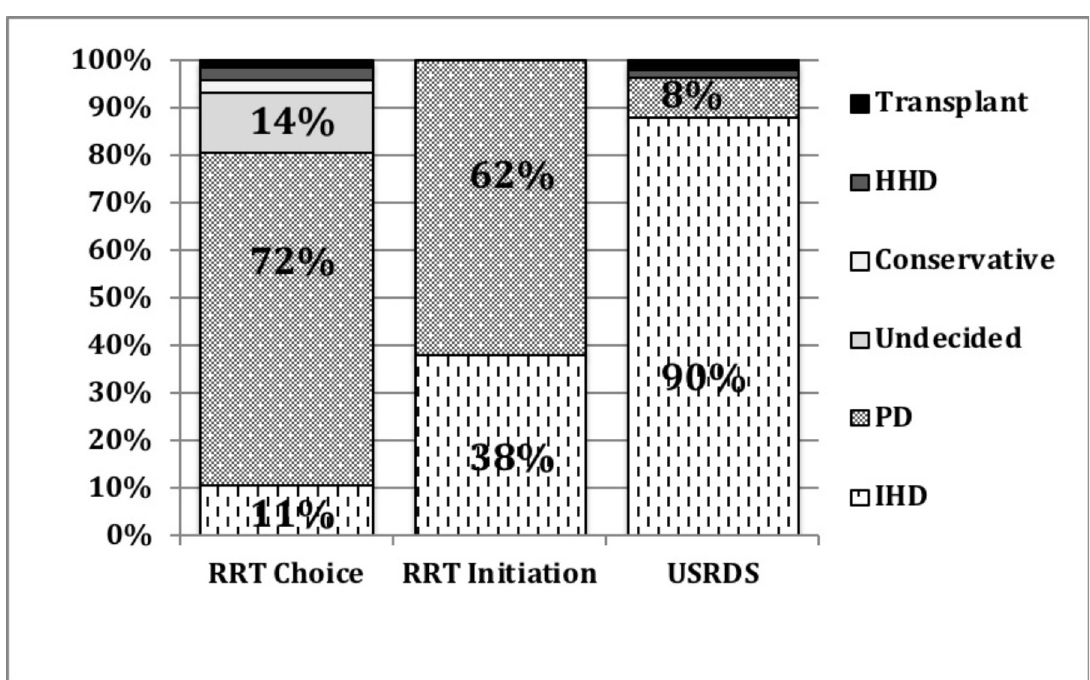
Fig 2. Impact of CPE on the choice and use of HoD compared to the prevalent USRDS data. Fig 2 shows the impact of CPE on the selection and use of various renal replacement therapies compared to the concurrent prevalent USRDS data. [27] HHD: Home hemodialysis; PD: peritoneal dialysis; IHD: In-center hemodialysis; RRT: Renal replacement Therapy.